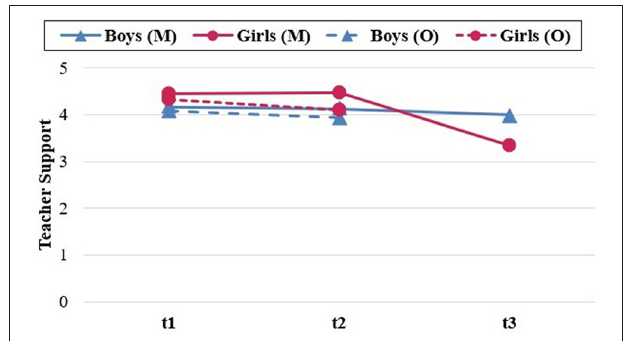
FIGURE 1 | Turkish students’ teacher support over time separated by cohort and gender.